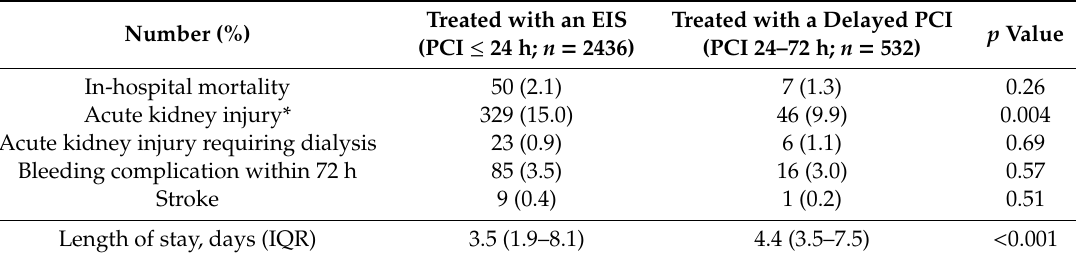
Table 2. In-hospital outcomes.